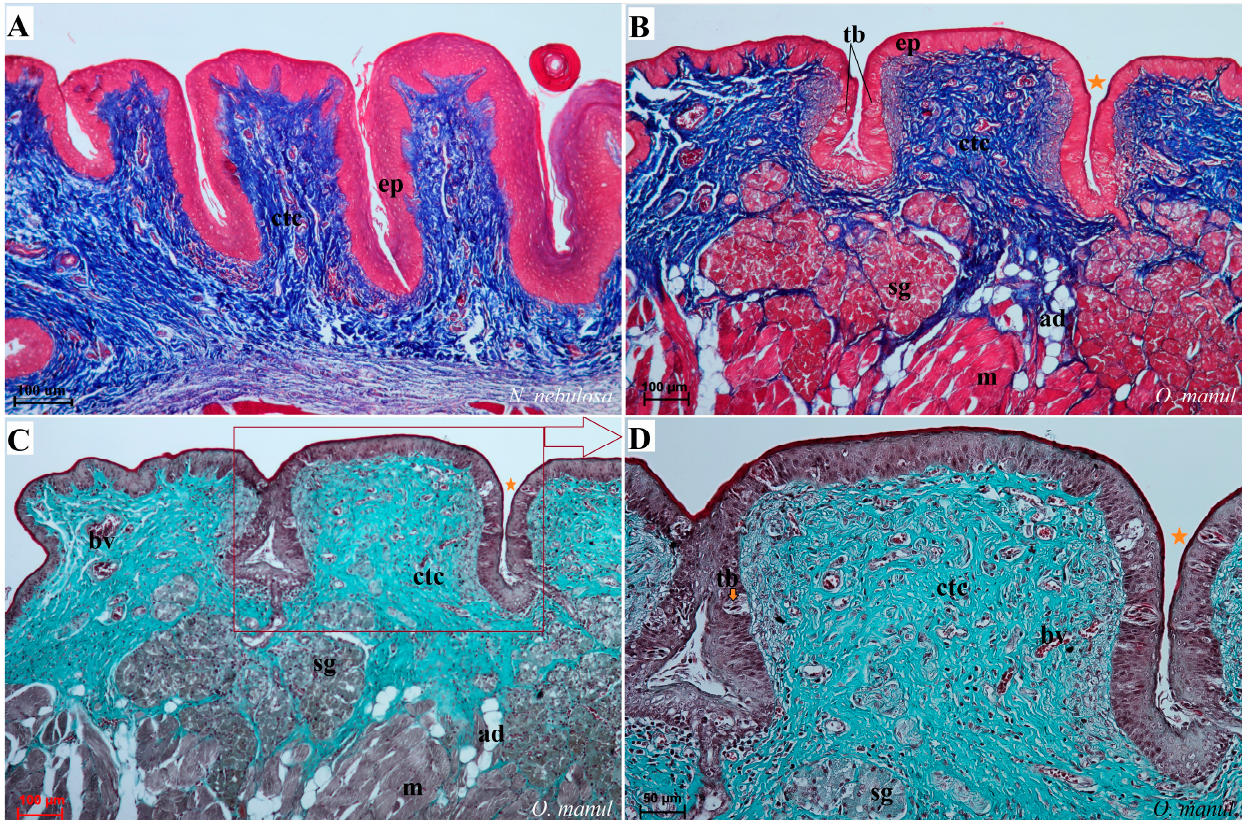
Figure 11. Histological pictures of the foliate papillae area of the tongue of N. nebulosa ( A ) and O. manul ( B – D ). ( A ) Lack of taste buds within the lateral side of the tongue within the epithelium of the foliate papillae. ( B , C ) Foliate papillae with several well-visible elongated taste buds beneath the papillae serous lingual glands are present. Deep sulcus of the foliate papilla (orange asterisk). ( D ) Magnification of the foliate papilla fold with several taste buds (orange arrow). Azan trichrome staining ( A , B ); Masson–Goldner trichrome staining ( C , D ). Bar = 100 µm (A–C); bar = 50 µm (D).